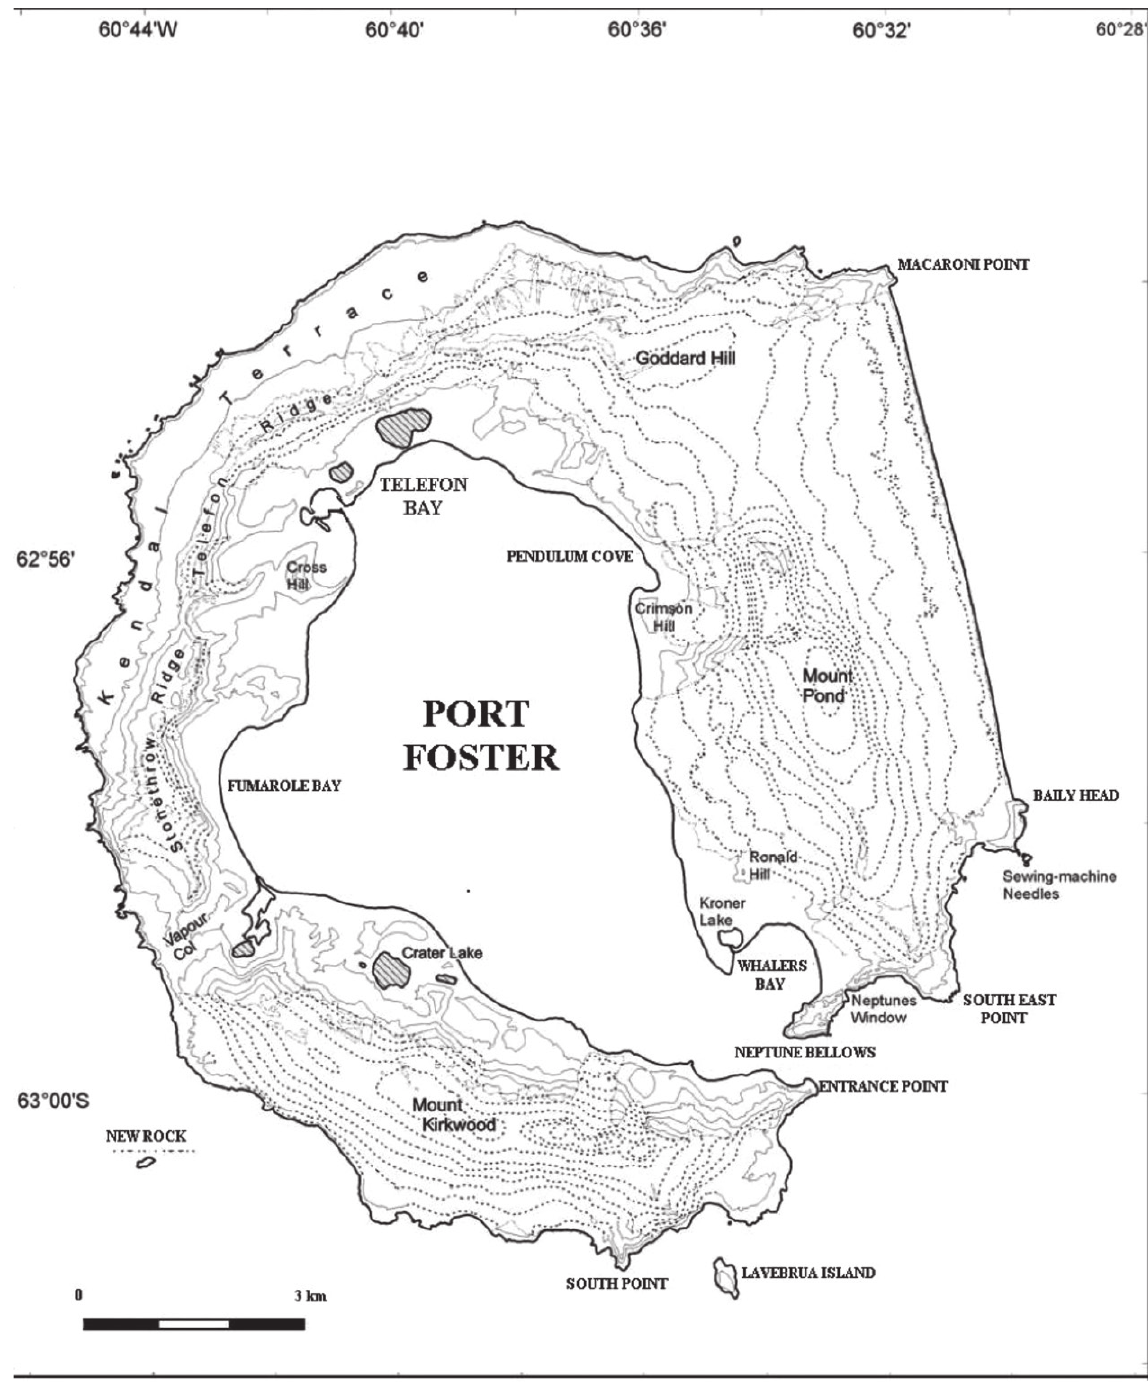
Figure 2 – Deception Island map, where all ice free areas were visited. 1990) and Czeczuga and Xavier-Filho (1987, 1988), describing beta-carotenoid, natural products and the antimicrobial activity of several lichen